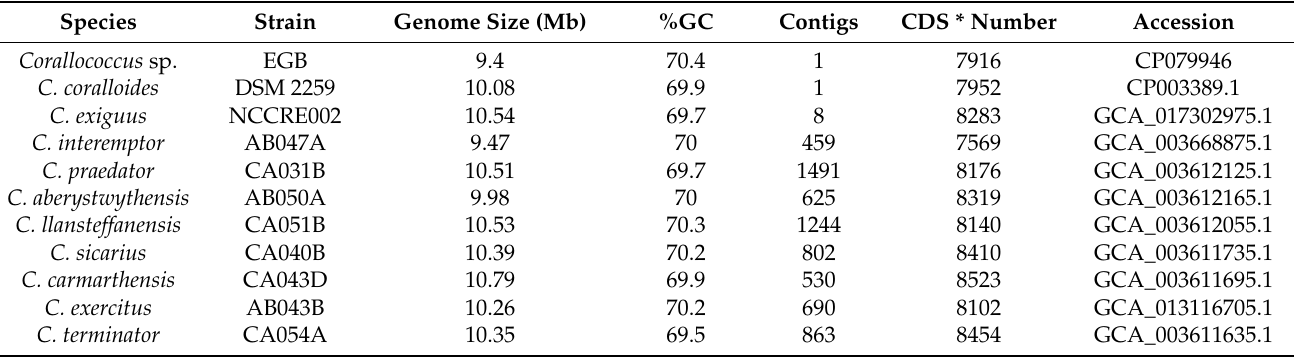
Table 1. Genome properties of Corallococcus